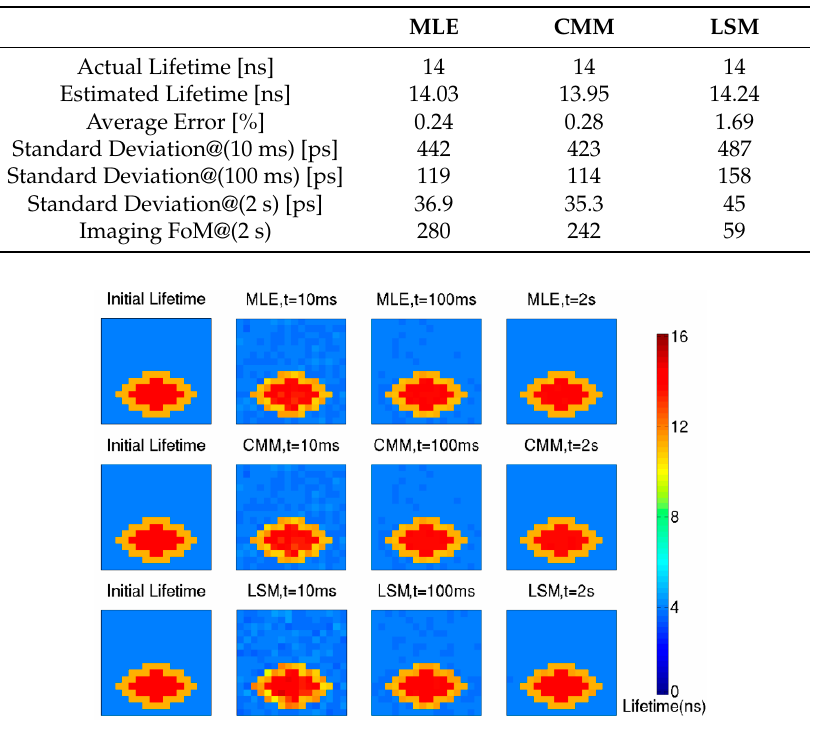
Figure 14. The simulation result of No. 2 picture. The simulation results above indicate that moderate measurement accuracy is attainable using full parallel event driven readout method. The CMM and MLE algorithm can be put in use for estimating fluorescence lifetimes. MLE is capable of extending the lifetime resolvability range with a high performance computer. But the CMM shows its advantage in the easy implementation of hardware.